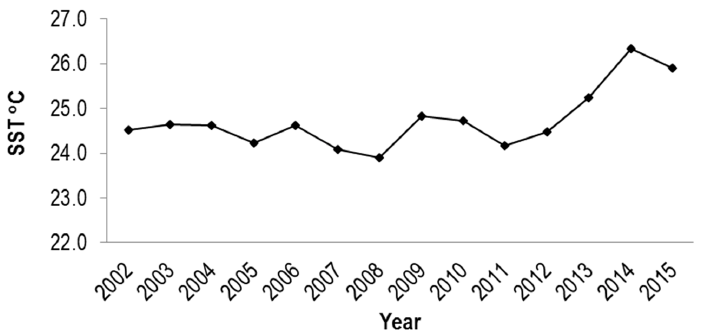
Figure 10. Average annual variability of sea surface temperature in the central and southern coastal region of Sonora, Mexico, and adjacent oceanic zone in the Gulf of California.